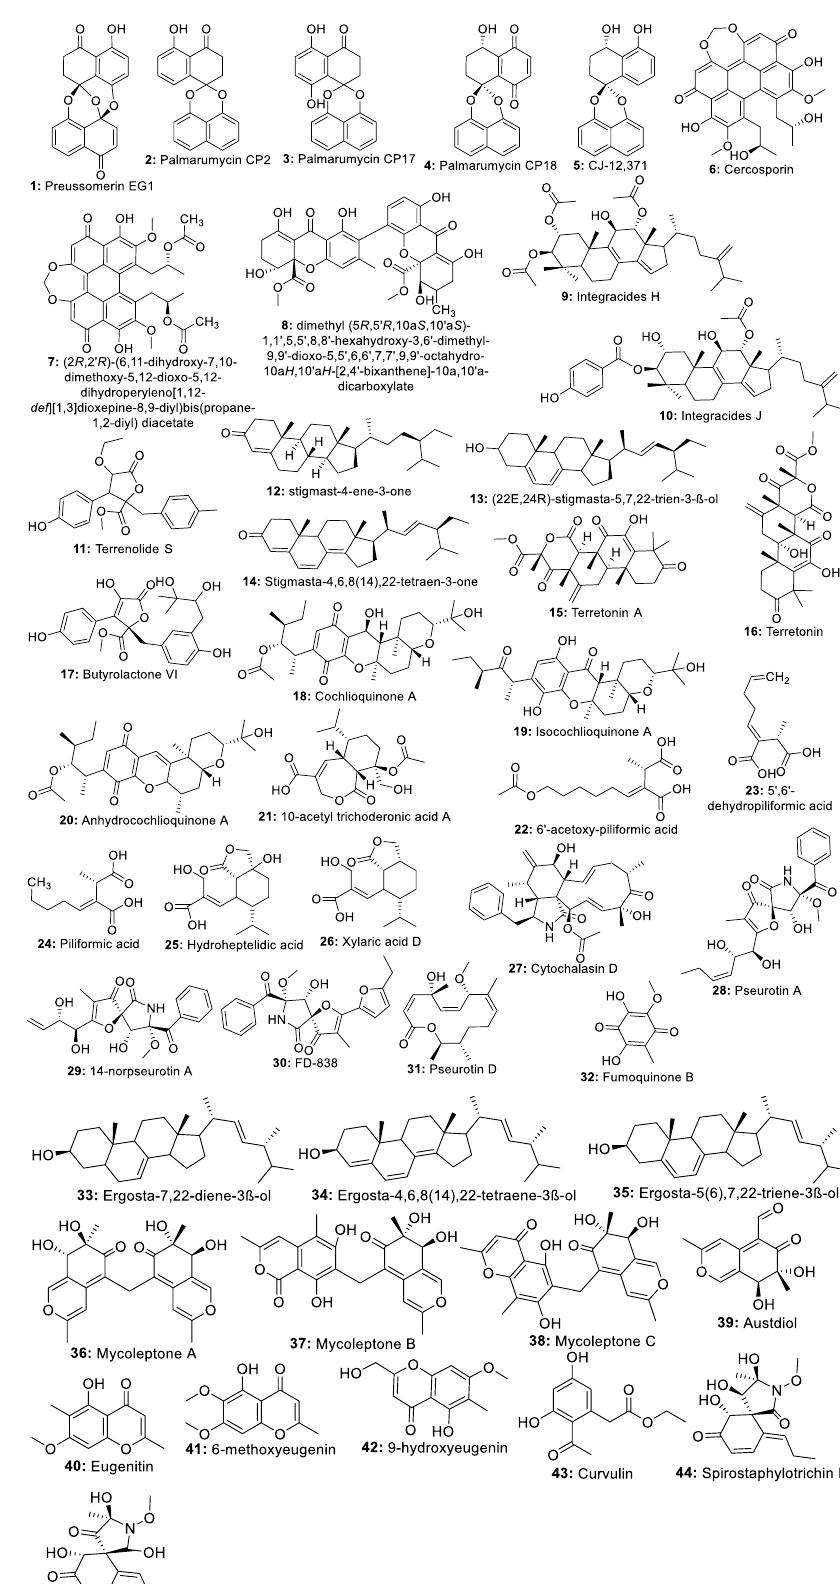
Fig. 1 Metabolites active against Leishmania spp. isolated from endophytic